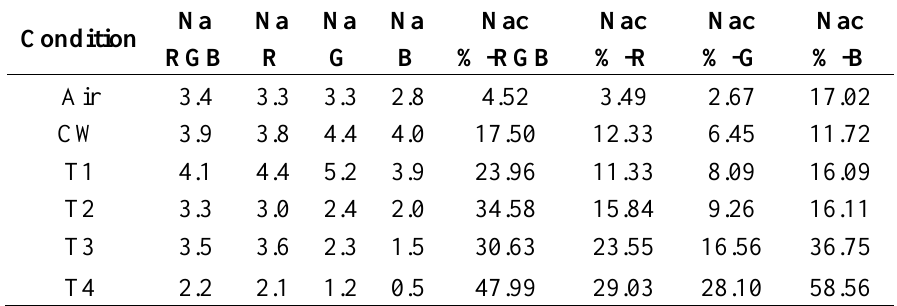
Table 4. Percentage values of deleted 3D points for active stereo technique in each